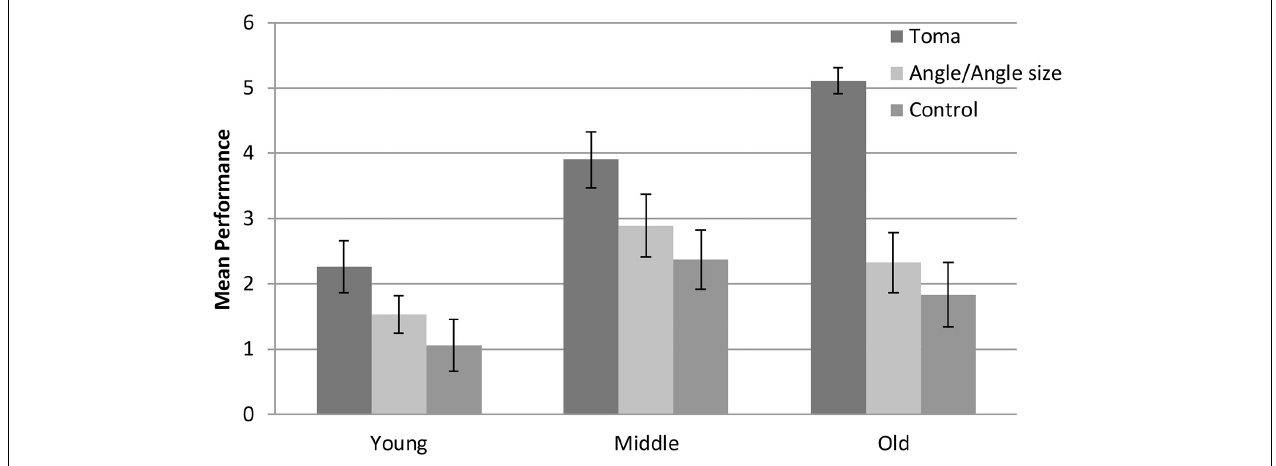
FIGURE 3 | Mean post-test performance on length-inconsistent tasks by condition and age group.